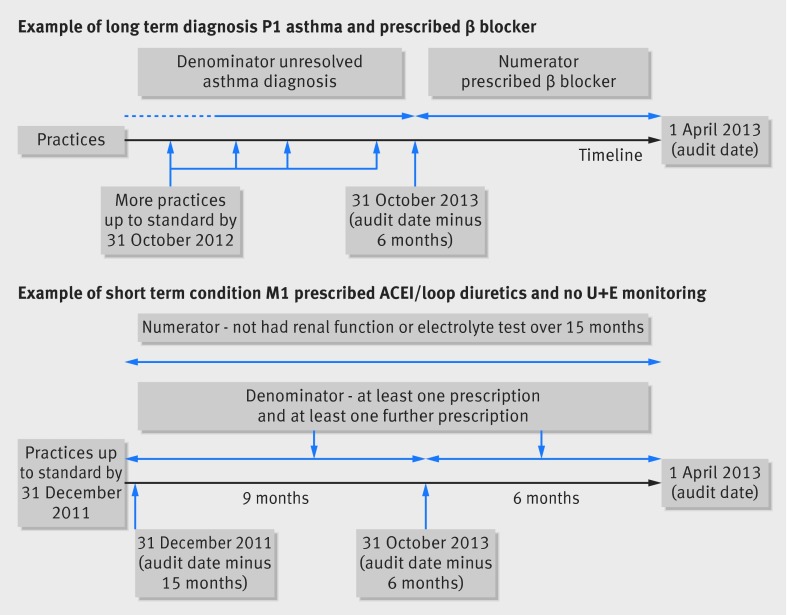
Fig 1 Examples of indicator definitions